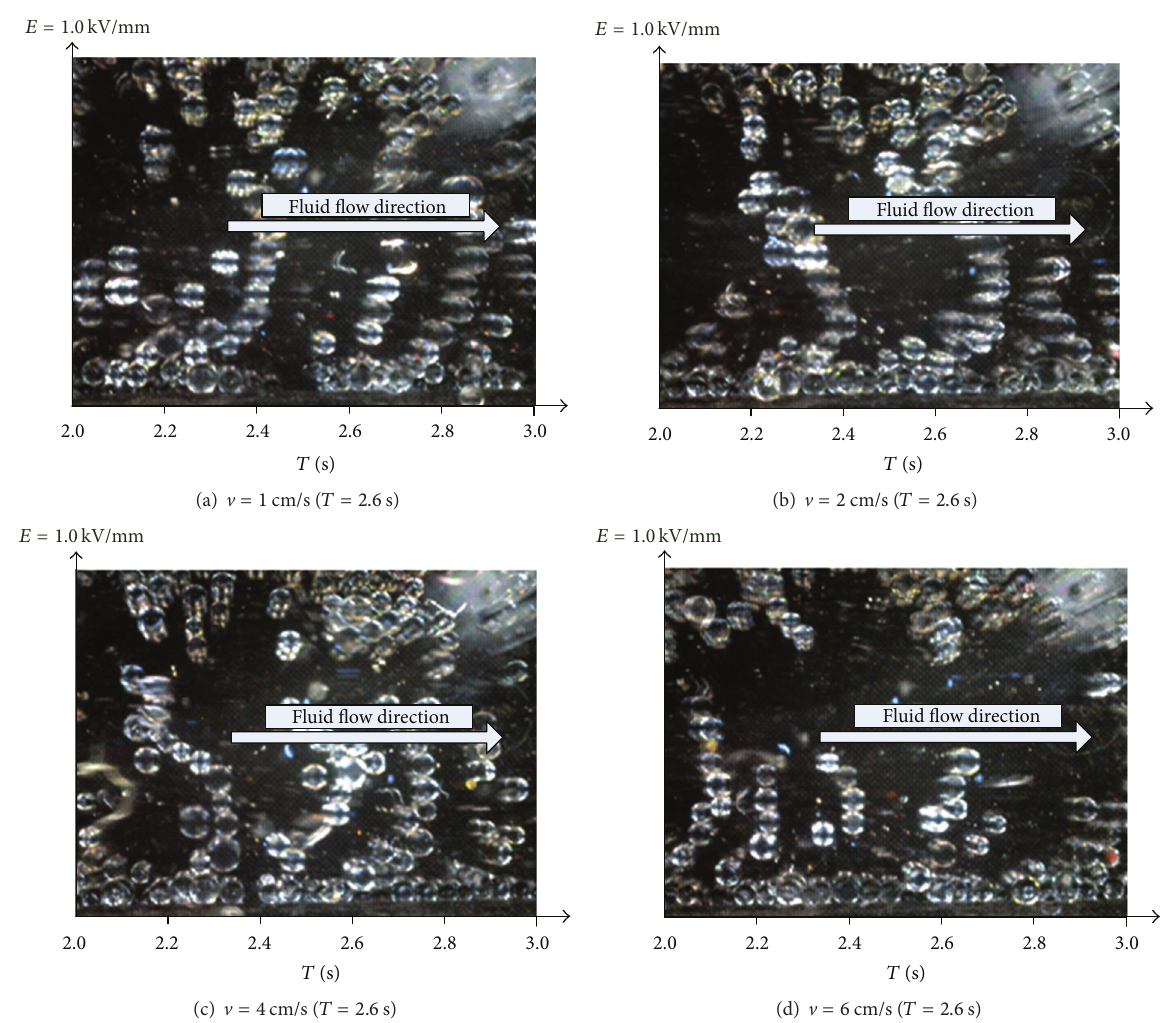
Figure 6: Structural evolution of the ER fluids at different pressure gradient ( 𝐸 = 1.0